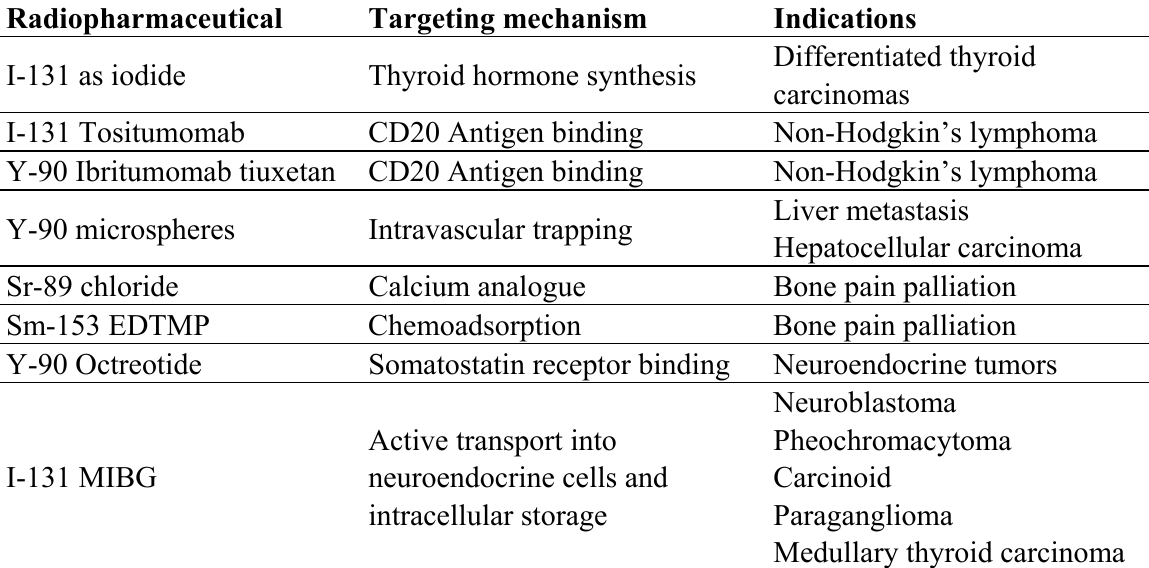
Table 2. Commonly used radiopharmaceuticals for targeted